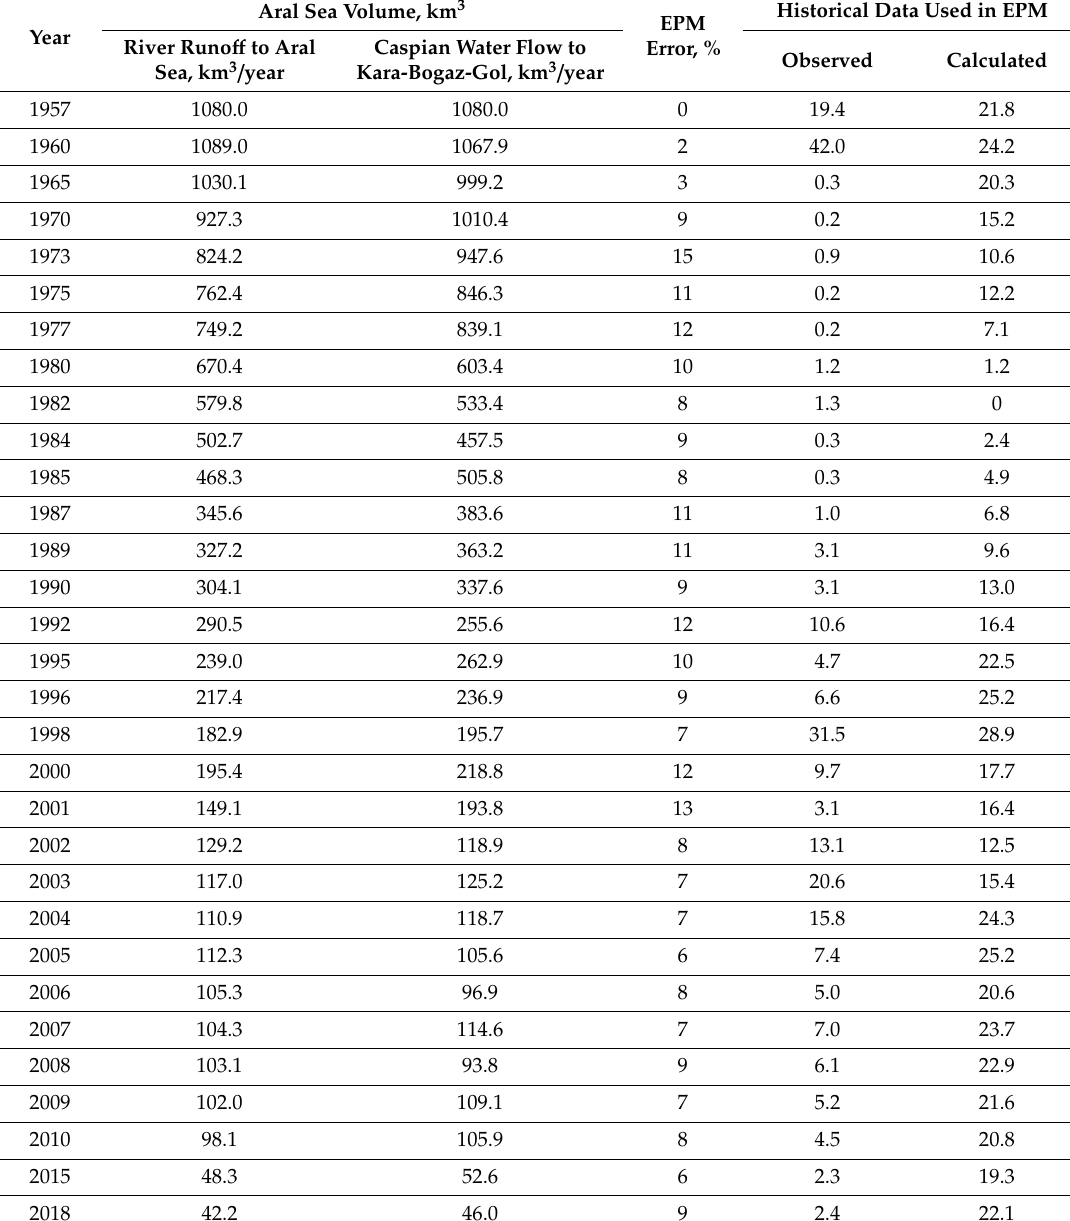
Table 5. Comparison of observed and calculated Aral Sea levels [3,35,60]. EPM = Evaporation / Precipitation